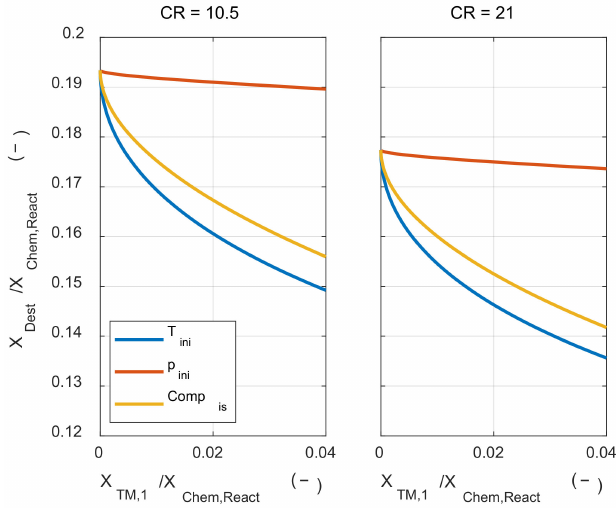
Figure 9. The exergy destruction under various initial thermodynamic states with a di ff erent compression